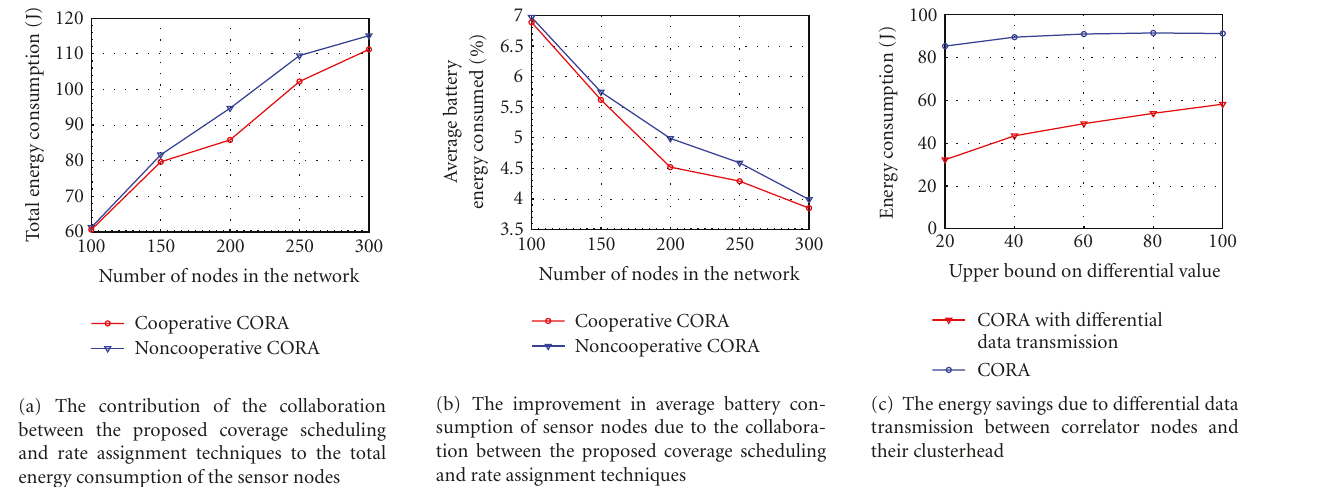
Figure 9: Performance evaluation of the collaboration between the proposed coverage scheduling and rate assignment techniques and the energy gains obtained from the di ff erential data transmission